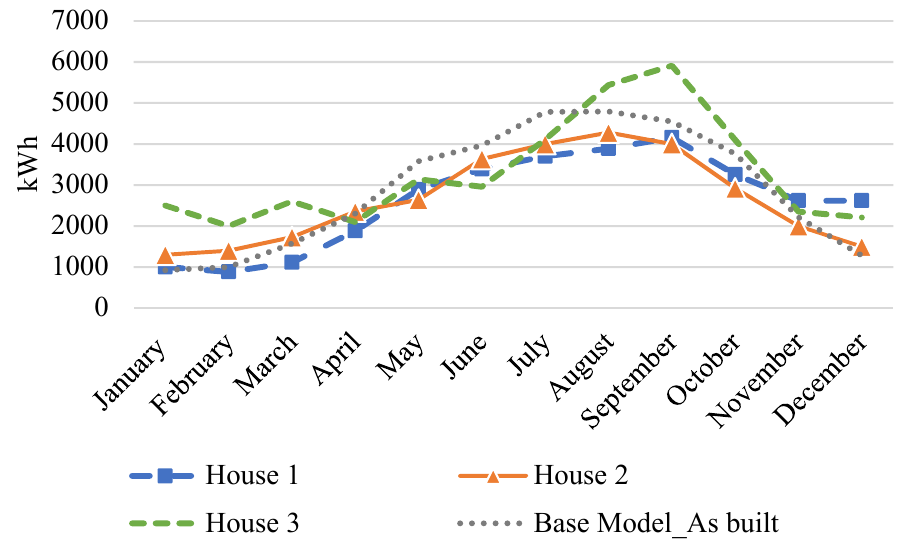
Figure 7. The three residential buildings’ actual monthly electricity usage and those of Design- Builder.